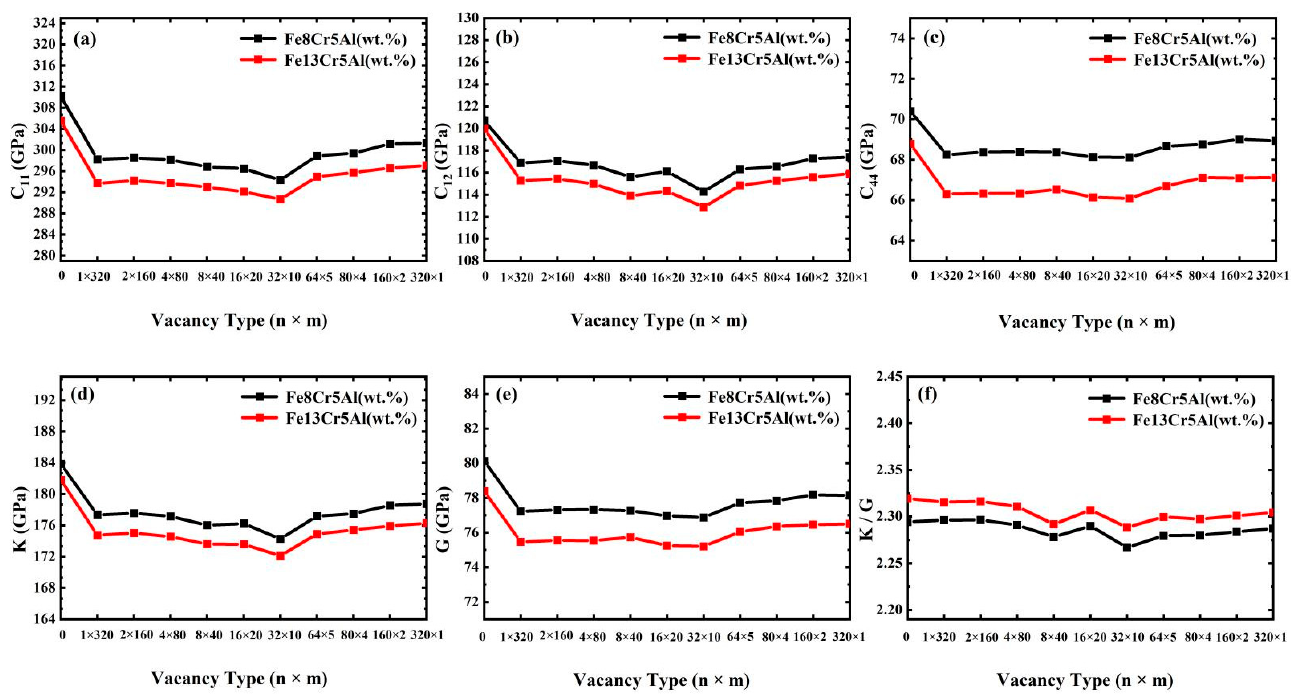
Figure 5 . ( a – e ) The effects of vacancy and void on C 11 , C 12 , C 44 , bulk modulus and shear modulus, ( f ) shows the value of K/G as a function of vacancy type. In these figures, n is the number of vacancies in each vacancy cluster or void and m is the number of vacancy clusters or voids.